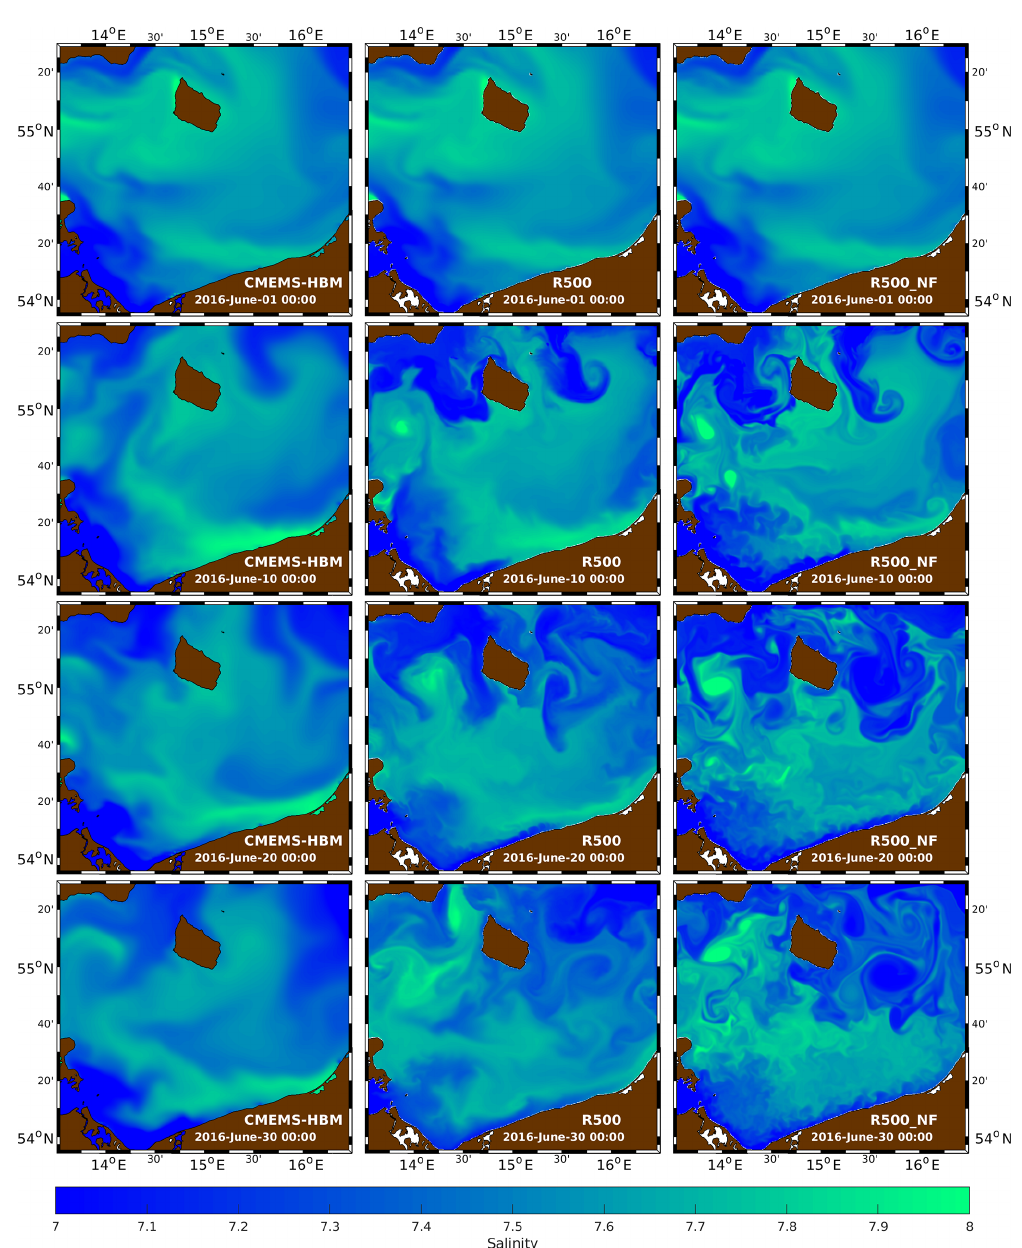
Figure 2. Top-layer salinity in CMEMS-HBM (left column), R500 (centre), and R500_NF (right) for 1, 10, 20, and 30 June. The CMEMS- HBM fields are interpolated onto the R500 horizontal grid. Due to the coarser horizontal grid of CMEMS-HBM, inland lakes are not resolved, and salinity values were assigned to places that are dry in